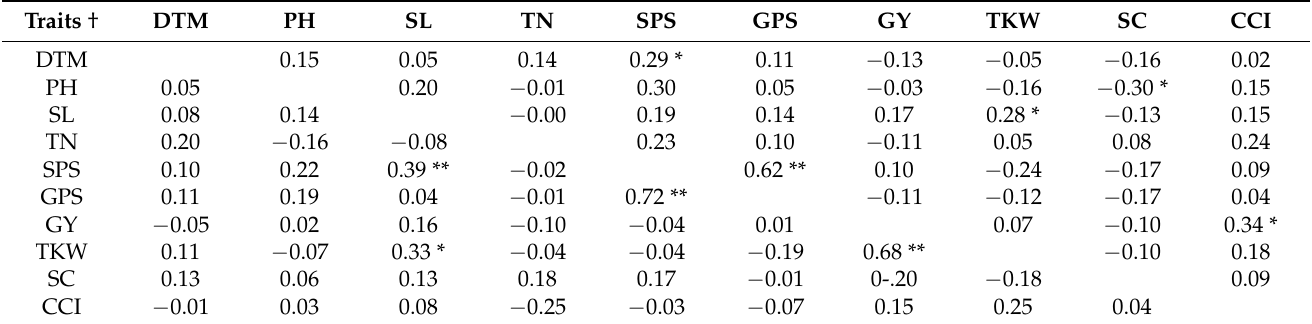
Table 4. Pearson correlation coefficients showing associations between assessed agronomic and physiological traits among 10 wheat parental genotypes and crosses under irrigated (lower diagonal) and terminal drought (upper diagonal) in the RS environment.